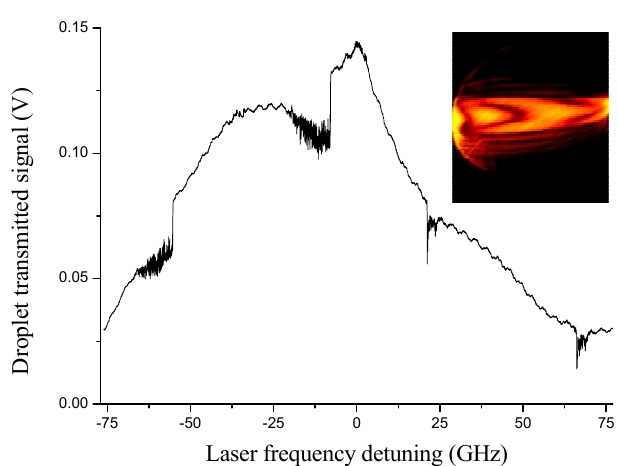
Figure 12. Optical resonances are shown as observed on the transmission of a 140- µ m radius droplet along an ascending and descending wavelength scan, from left to right, respectively. Fast oscillations and broadening effects are observed on the resonances. In the inset, a camera image of the out-scattered radiation when the laser is resonant with the strongest mode (Reproduced with permission from [61]).